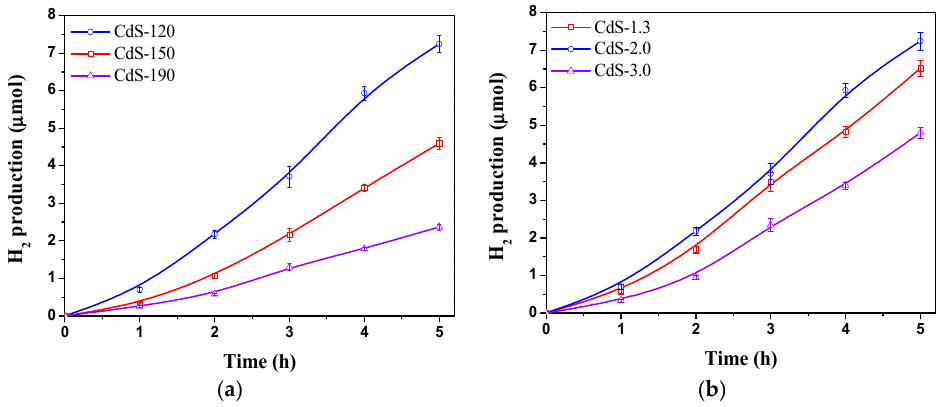
Figure 8. Hydrogen production on CdS photocatalysts: ( a ) influence of solvothermal temperature (CdS-120, 150 and 190); ( b ) influence of H 2 O/thiourea ratio (CdS-1.3, 2.0 and 3.0) (150 W Xe lamp, 0.05 g CdS photocatalyst, 150 mL aqueous solution 0.05 M Na 2 S/0.02 M Na 2 SO 3 ).